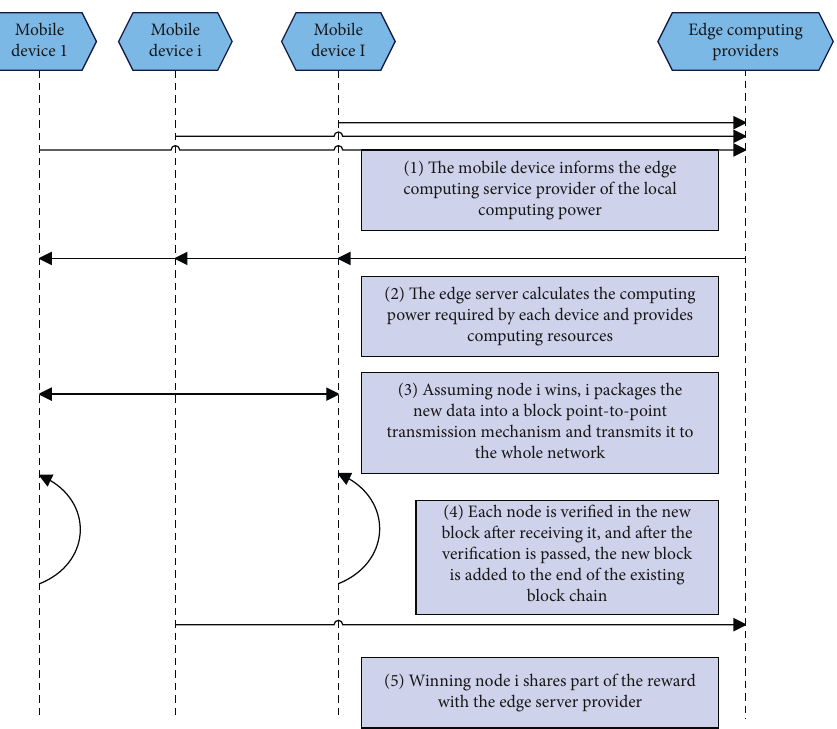
Figure 4: Flowchart of the interaction between the intelligent terminal and the edge server.